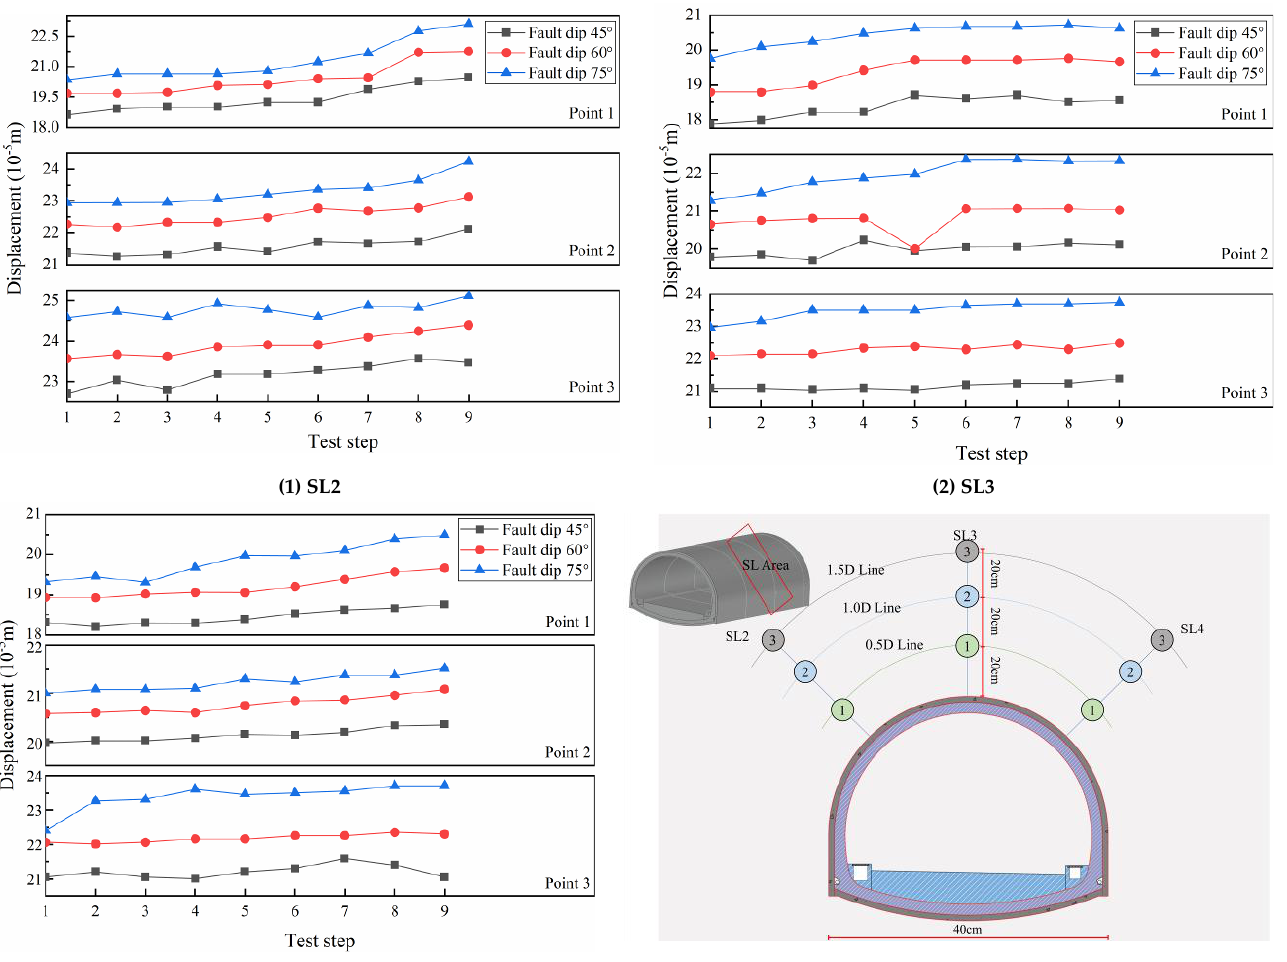
Figure 11. Line chart of rock mass deformation in the CD method.